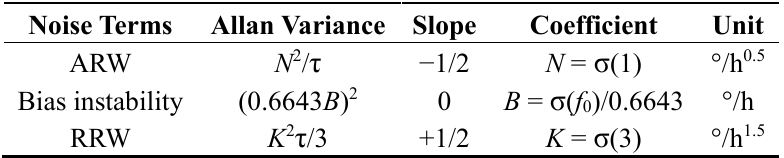
Table 1. Noise terms of MEMS gyroscope by Allan